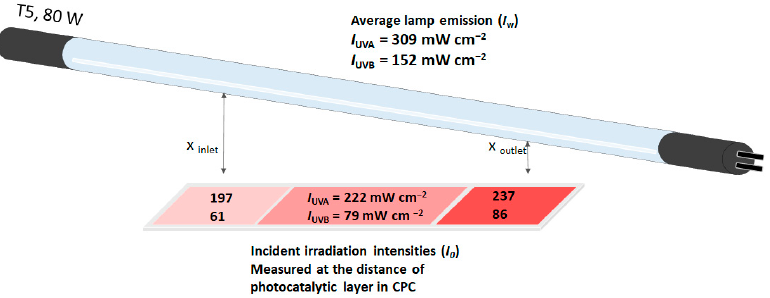
Figure 9. Average incident irradiation intensities on photocatalyst surface in CPC regarding lamps’ positioning.